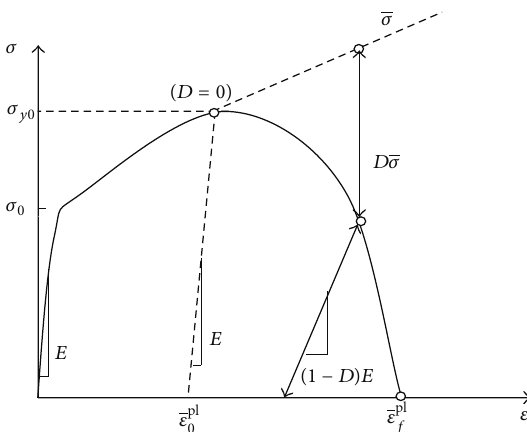
Figure 5: Stress-strain curve with progressive damage degradation (ABAQUS Analysis User’s